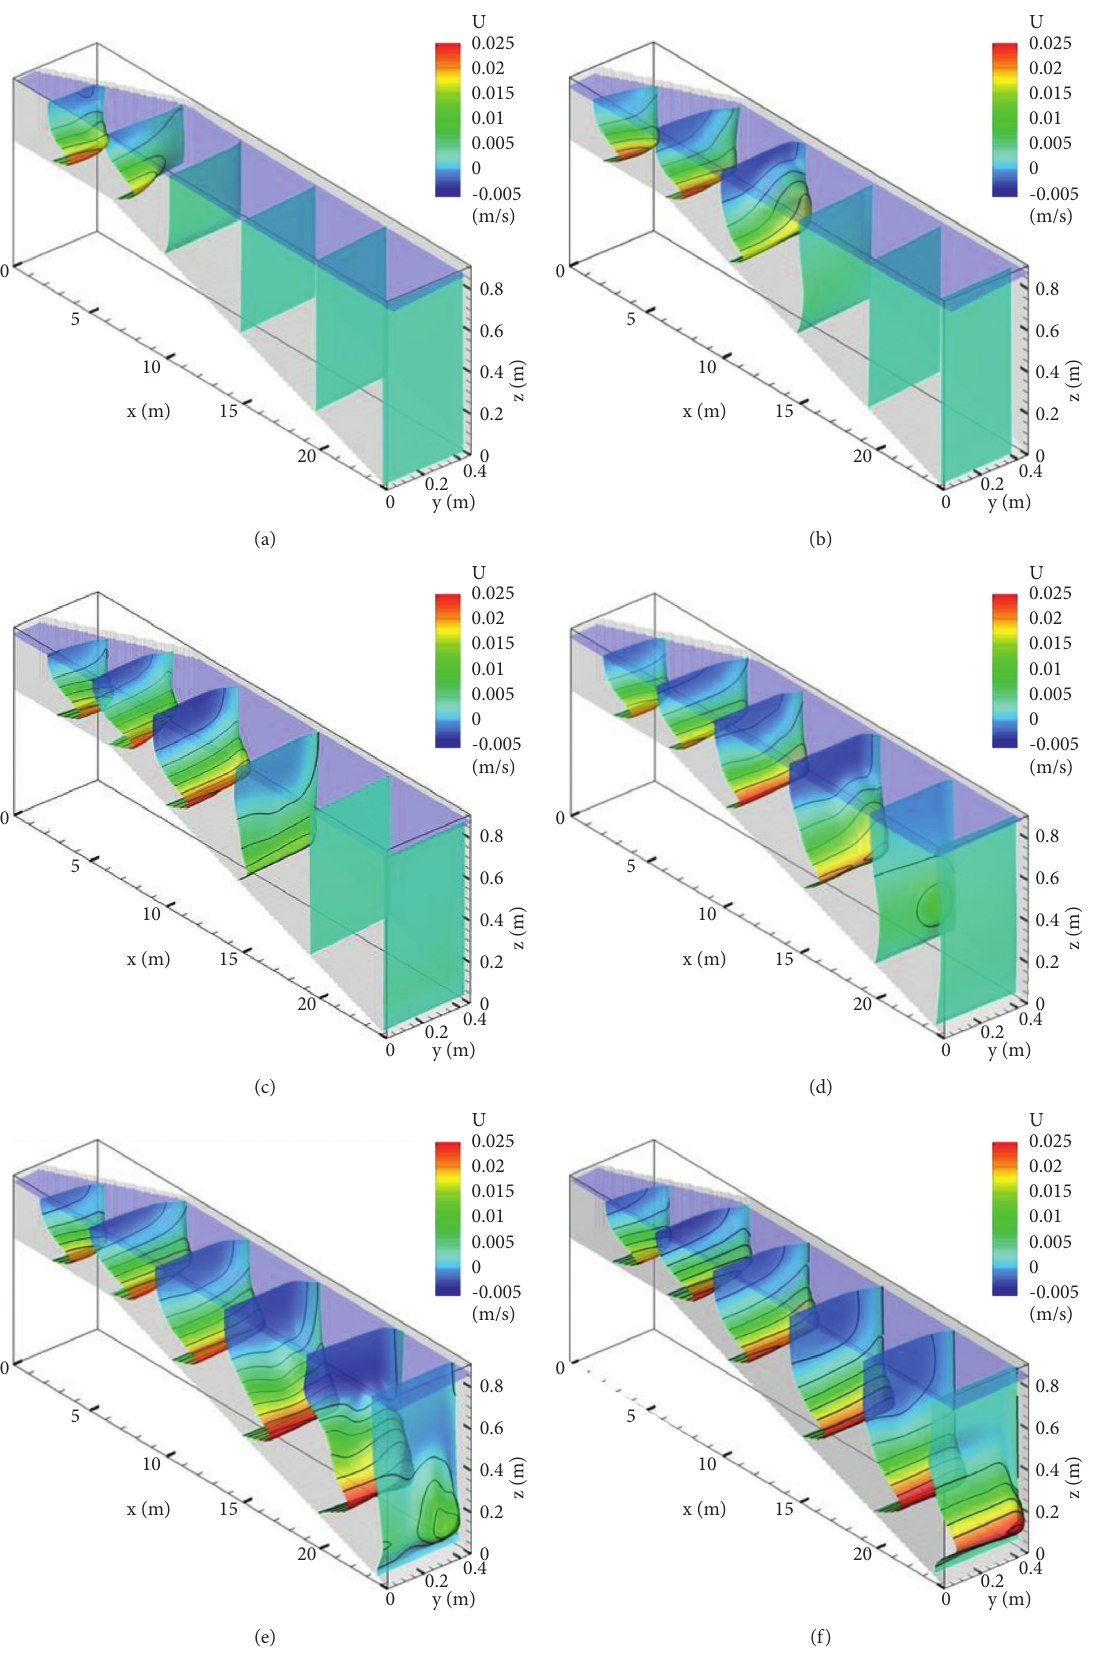
Figure 8: Water surface and velocity of the model reservoir at different times: (a) t � 4min, (b) t � 8 min, (c) t � 12min, (d) t � 16min, (e) t � 20min, and (f) t �